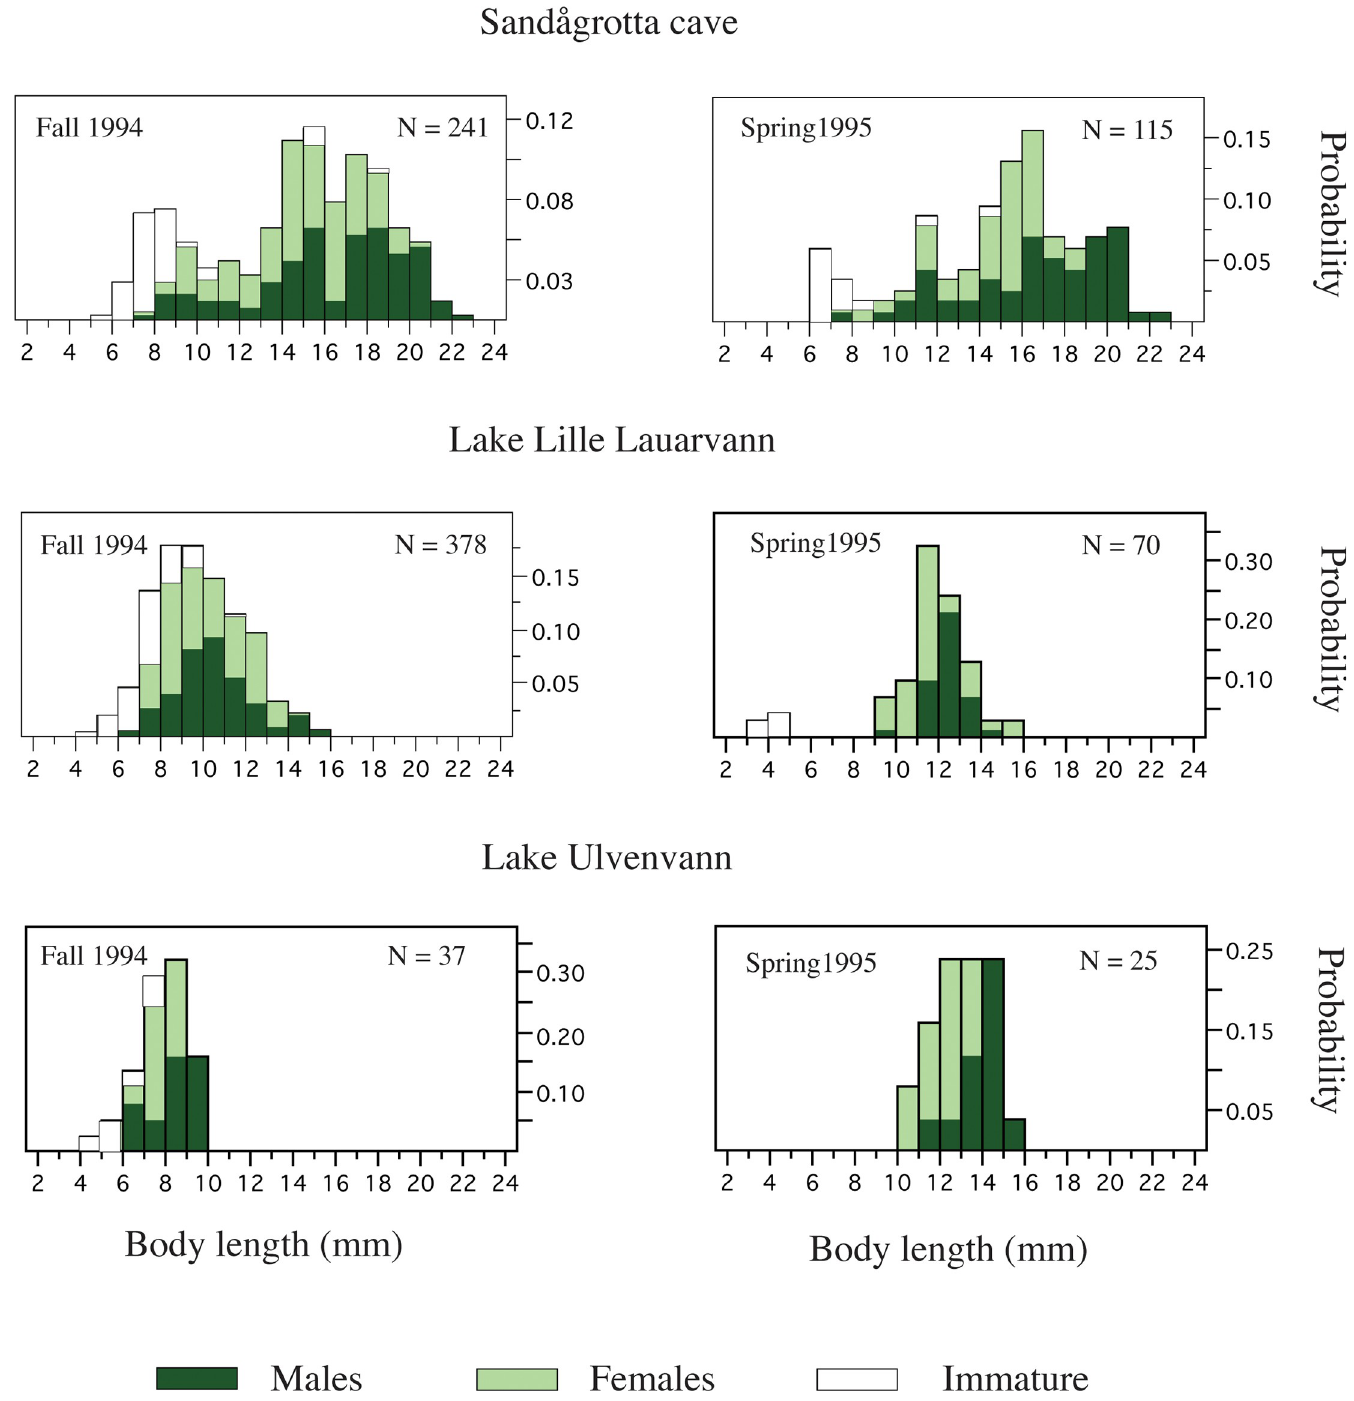
Fig 3. Body size distribution pattern. Autumn and spring body size distribution in the Sand å grotta Cave, and the surface populations of Lake Lille Lauarvann and Lake Ulvenvann. The color codes are as follows; white bars = immature individuals, ligth green bars = females and dark green = males. The vertical scale denotes the probability of finding different size-classes within these population. The sample size for each site and temporal comparison is given within each of the six figures.